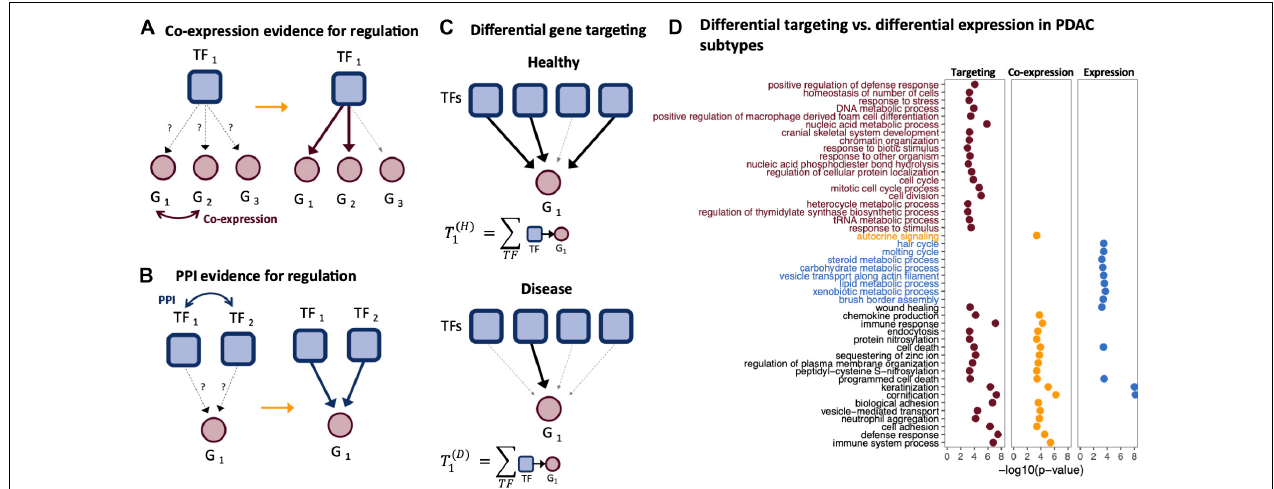
FIGURE 2 | Gene targeting. Gene targeting scores are derived from gene regulatory networks (GRNs) and thus are influenced by the components used to derive the edge weights of a GRN. For example, PANDA GRNs include information regarding the (A) co-expression relationships between genes and (B) protein–protein interactions between transcription factors (TFs). (C) Gene targeting scores are calculated as the sum of the weights across all inbound edges pointing to a gene. (D) Gene Ontology (GO) enrichment of ranked differential gene scores comparing the basal-like and classical pancreatic ductal adenocarcinoma (PDAC) subtypes. Genes were ranked by differential targeting (red), differential co-expression (orange), and differential expression